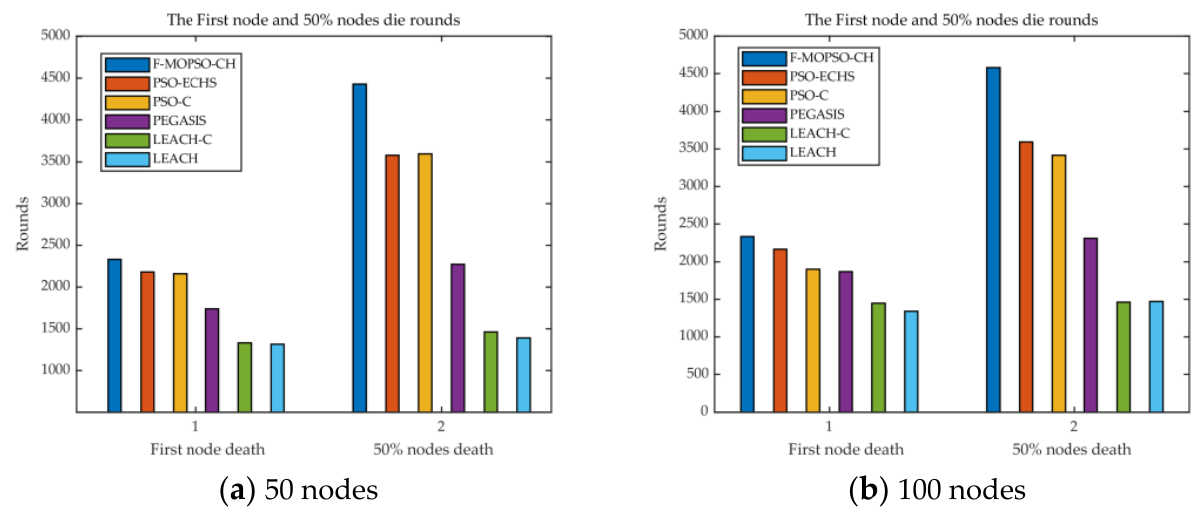
Figure 12. Comparison of the FND and the HND for ( a ) 50 and ( b ) 100 nodes. From Figure 12a, for 50 nodes, compared with PSO-ECHS, PSO-C, PEGASIS, LEACH- The improved ACO was applied for the optimal trajectory of MS with a lower delay.